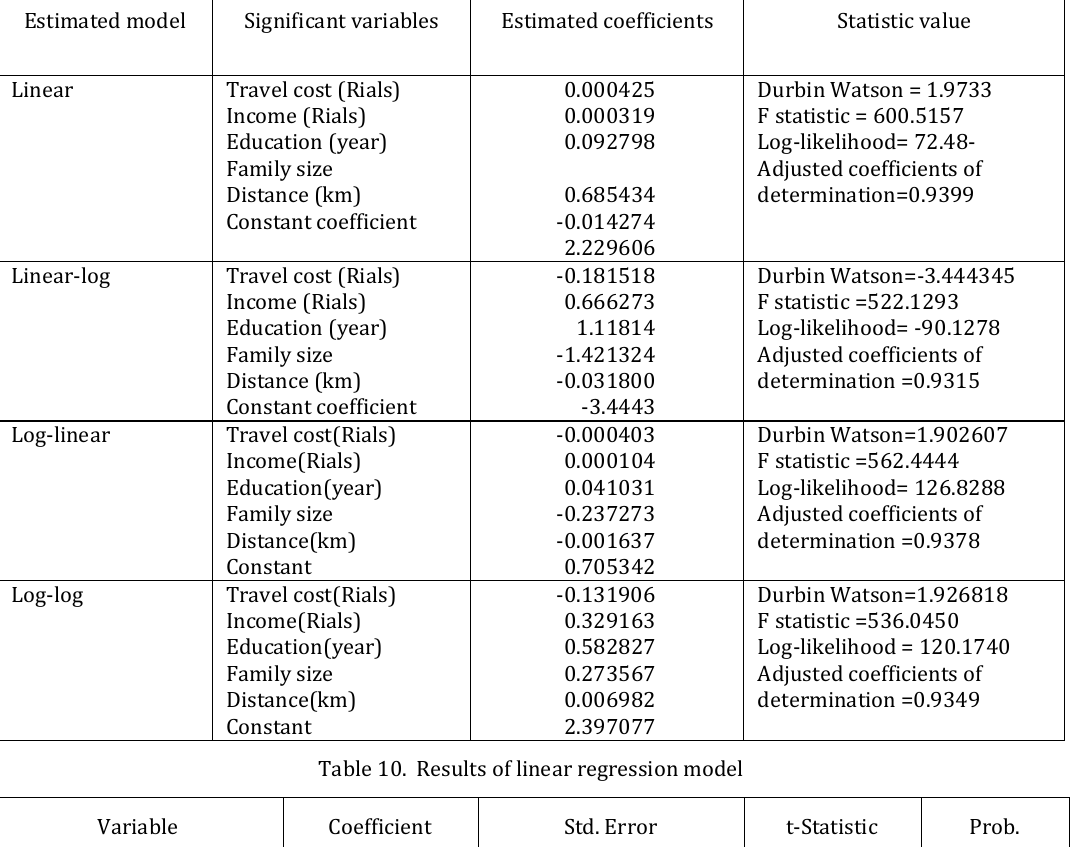
Table 10. Results of linear regression